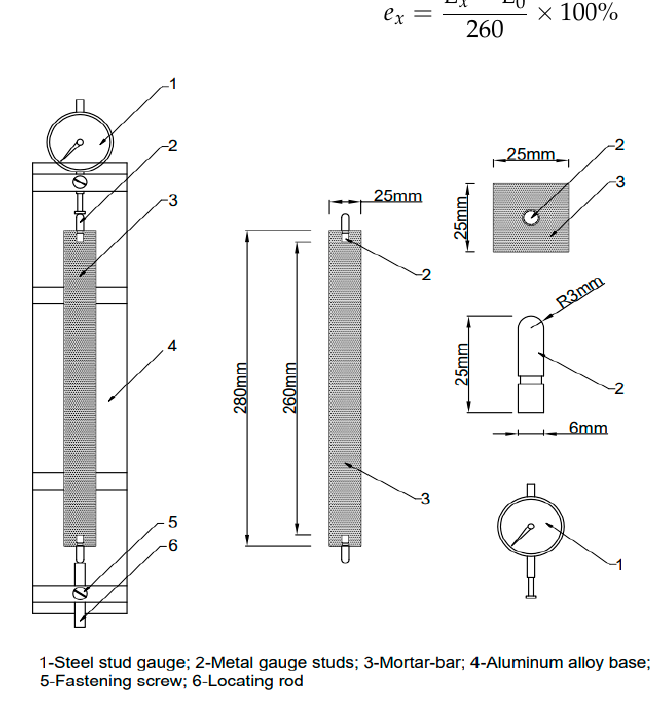
Figure 2. Schematic figure of ASR expansion test.